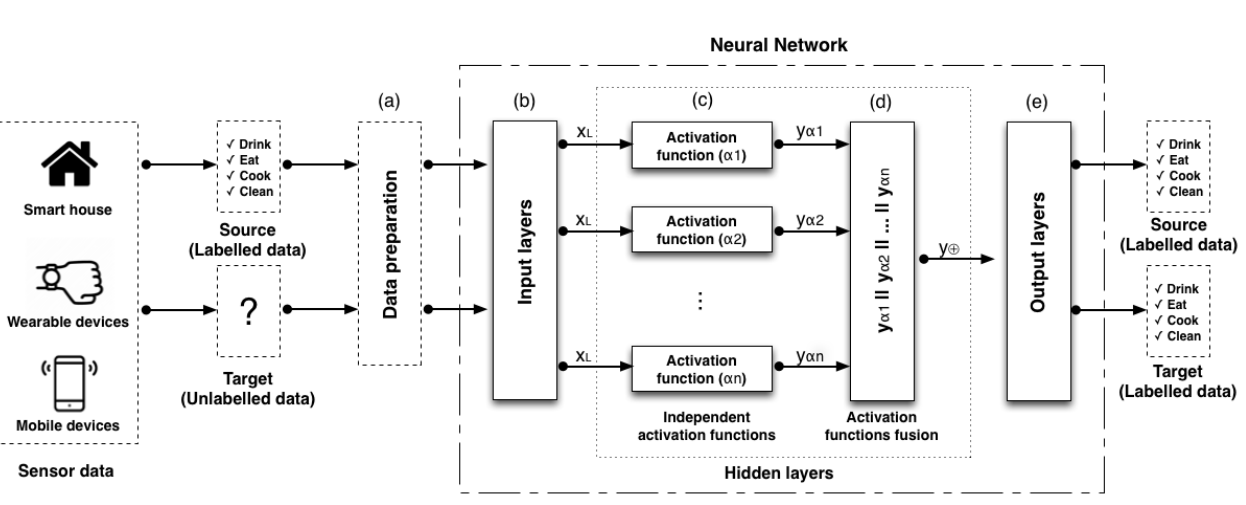
Figure 2. Flow diagram that illustrate the activation function fusion flow process. It begins by retrieving data from the different sensing technology (left side), fusing data collection of steps as it is the core structure of our methodology (centre), and output achieved (left side).